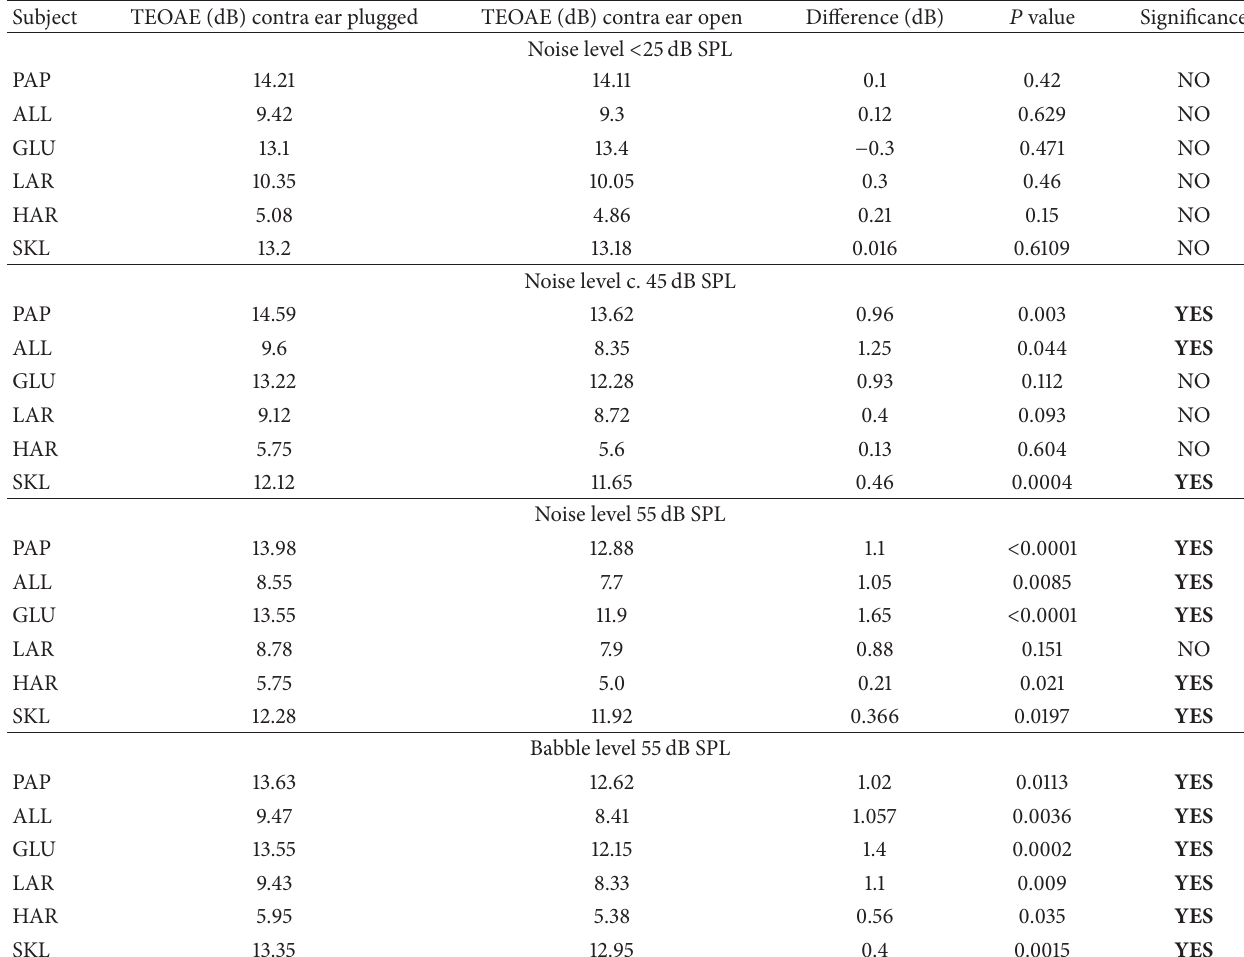
Table 1: TEOAE data from six subjects comparing OAE levels with contralateral ear occluded versus open. 𝑃 values of paired Student’s 𝑡 -test results and significance are